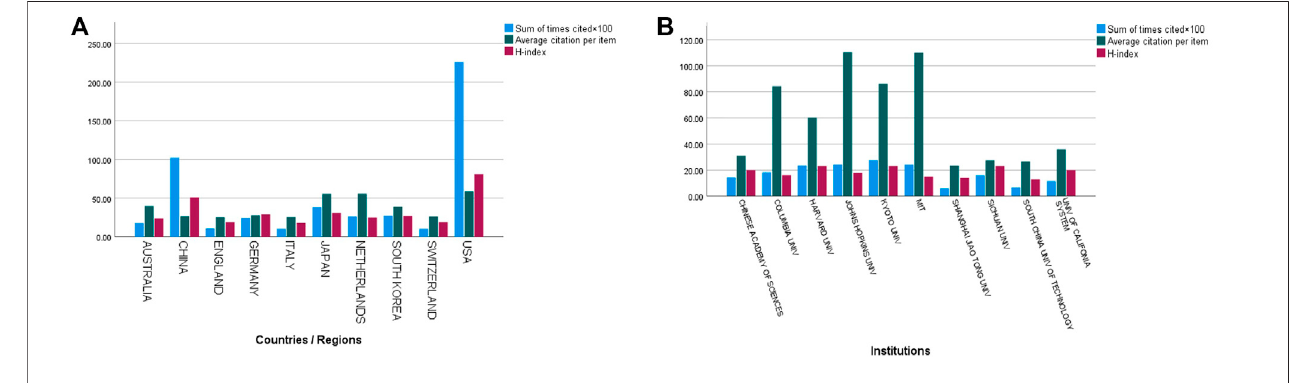
Figure 3 | Analysis of citation and H-index of different countries/regions and institutions. (A) Sum of times cited average citation per item and H-index of top 10 countries or regions. (B) Sum of times cited average citation per item and H-index of top 10 institutions MIT; Massachusetts Institute Of Technology.